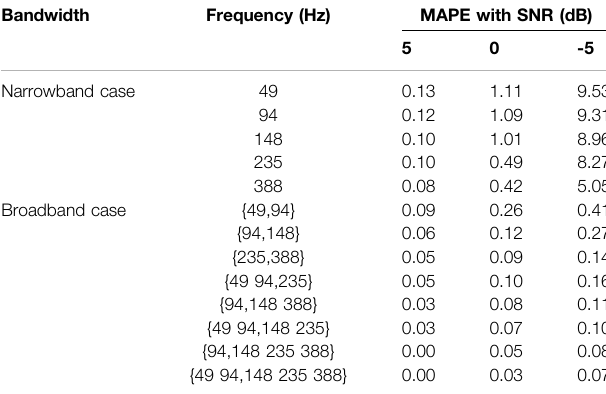
Table 2 | Range prediction results with narrowband and broadband cases.